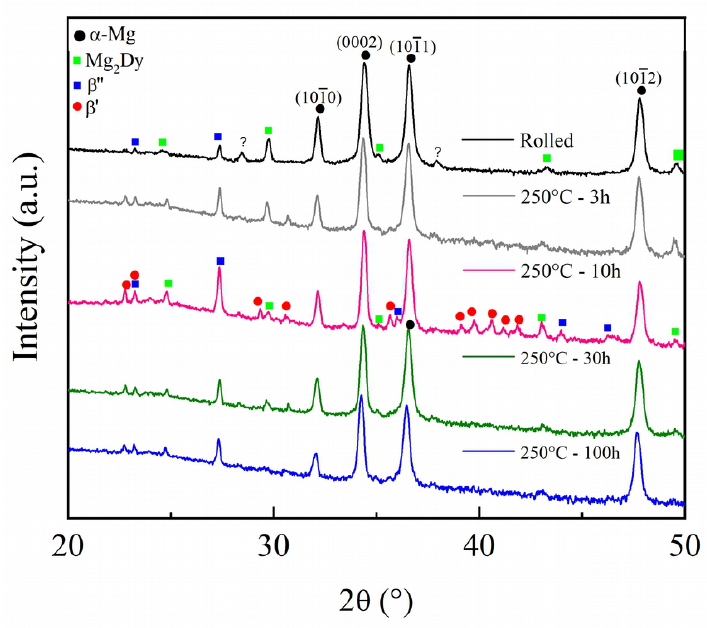
Figure 3. XRD diffractograms of rolled and aged